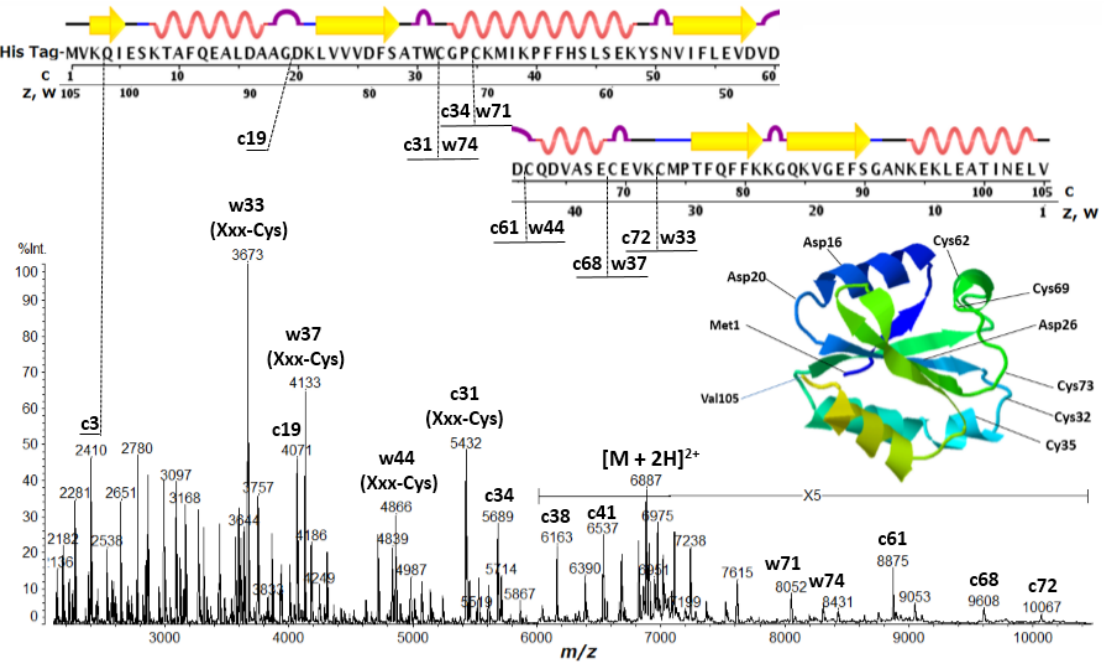
Figure 3. Positive ion MALDI-ISD spectrum of human thioredoxin with HisTag ( M r 13,769.6) obtained with 5-amino-1-naphthol matrix. The inset represents tertiary structure obtained by X-ray crystallography (PDB (protein data bank): 1AUC). The upper line represents primary and secondary structure (wave: α-helix, arrow: β-strand, convex: turn, straight: bend or